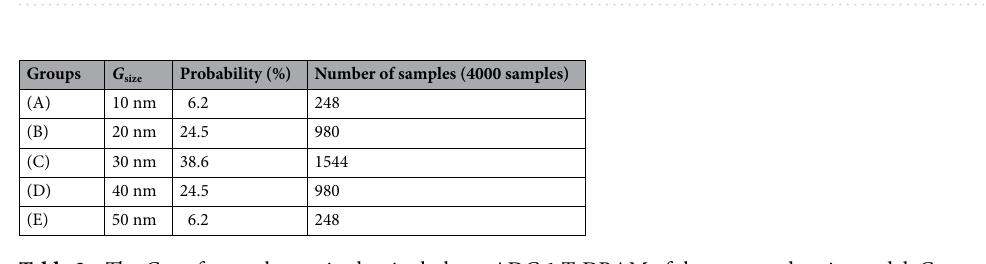
Table 2. The G size of several cases in the single-layer ADG 1 T-DRAM of the proposed grain model: Group (A), (B), (C), (D), and